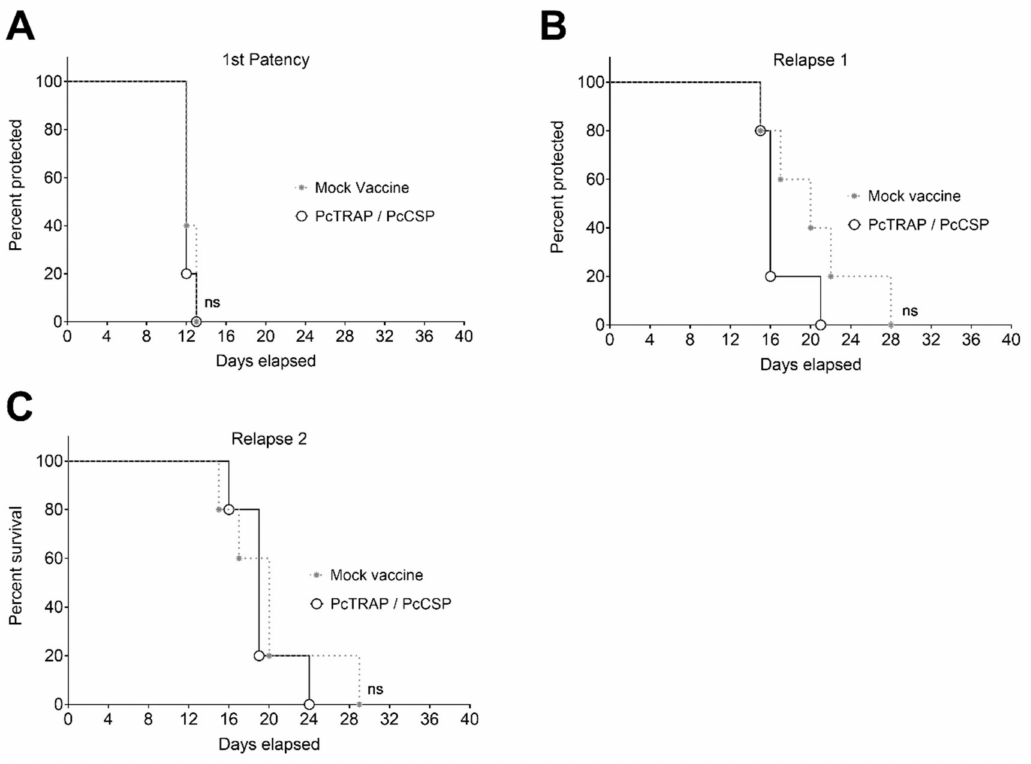
Figure 7. Macaques challenge with 10000 P. cynomolgi sporozoites. Macaques were followed to assess time and number of relapses; ( A ) 1 st patency, ( B ) First relapse and ( C ) Second relapse. Survival curves are represented as the time when the relapses occur. p -values were determined by the Kaplan–Meier method. p > 0.05